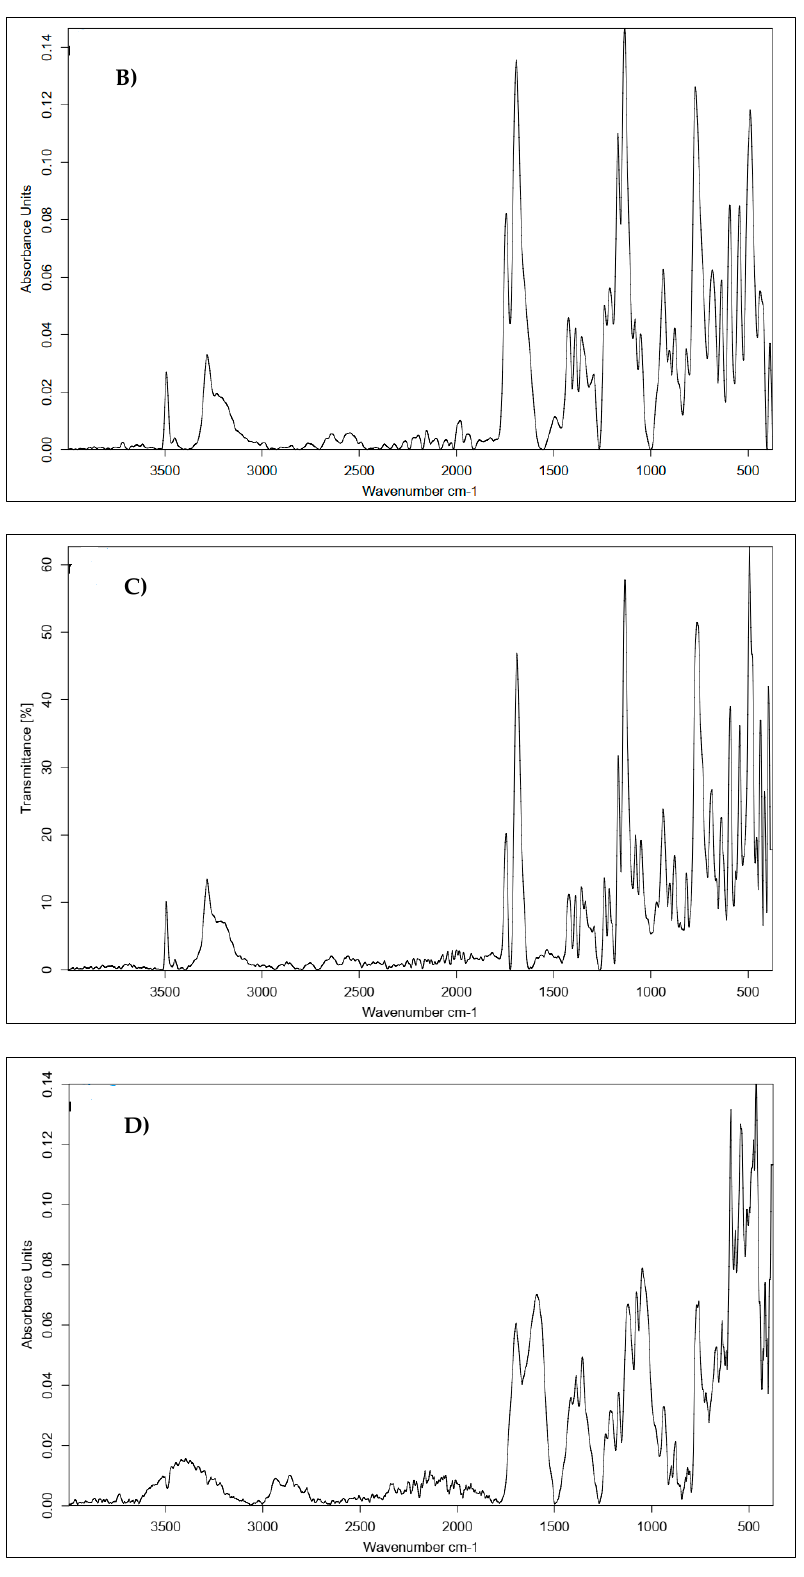
Figure 23. Comparison of the IR spectra obtained for the materials coated with the conjugate of hyaluronic acid–peptide (HA–KRMVRISRSL) cross-linked with different cross-linking agents. Approach: chemical modification of the coating layer. ( A ) Modified 0.5% HA and 20% CA; ( B ) modified 1% HA and 20% CA; ( C ) modified 2% HA and 5% CA; ( D ) modified 1% HA and